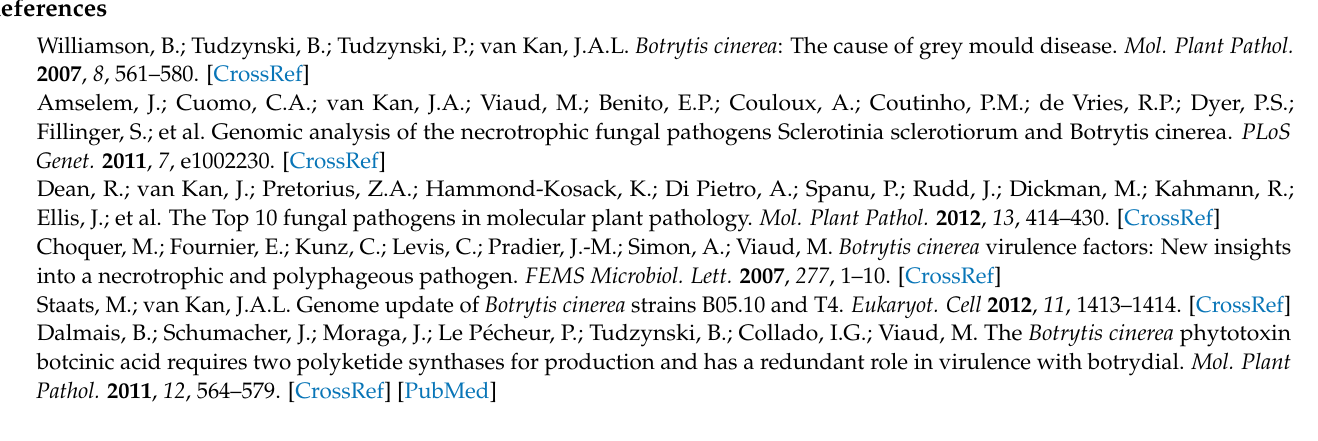
Table S3. Standard curve efficiency data for each Bcnrps gene and each reference gene used in the RT-qPCR assay, Table S4. Analysis of Bcnrps 1 orthologous genes in Ensembl Fungi Database, Table S5. Proteins sequences with significant alignment in BLASTP analysis, Table S6. Conserved Database. Figure S1. Expression profiles of the nine Bcnrps genes in B. cinerea strain B05.10 during Figure S2. Expression profiles of the nine Bcnrps genes in B. cinerea strain B05.10 during fermentation in 0.2% malt extract (ME) with or without 1.5 mM 1,3-Diaminopropane (1,3-DAP) supplement, Figure S3. Expression profiles of the nine Bcnrps genes in B. cinerea strain B05.10 during fermentation in 0.2% malt extract (ME) with or without 10 µ M spermine (SPM) supplement, Figure S4. Verification of the homologous integration of the replacement fragment and the absence of Bcnrps 1 alleles in two independent B. cinerea strains by means of a 1% ( w / v ) agarose gel electrophoresis. The amplification product to verify the homologous integration at 3 (cid:48) (1595 pb) and at 5 (cid:48) (883 pb). The transformants T1.2 and T1.4 displayed the expected PCR products for homologous integration of the KO construct, whereas the Bcnrps 1 allele was only amplified in the B. cinerea WT strain (427 pb). M: GeneRuler™ 1kb DNA